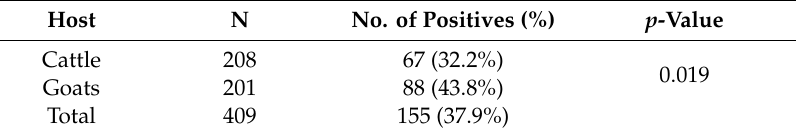
Table 2. Overall detection rates of hemotropic mycoplasma species in cattle and goats.